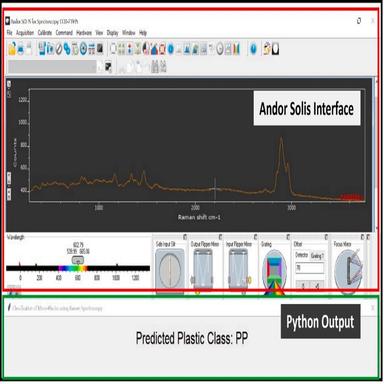
A screen shot of prediction results based on the spectral after recording the Raman spectra from unknown plastic, the prediction result shows the type as 'PP'.